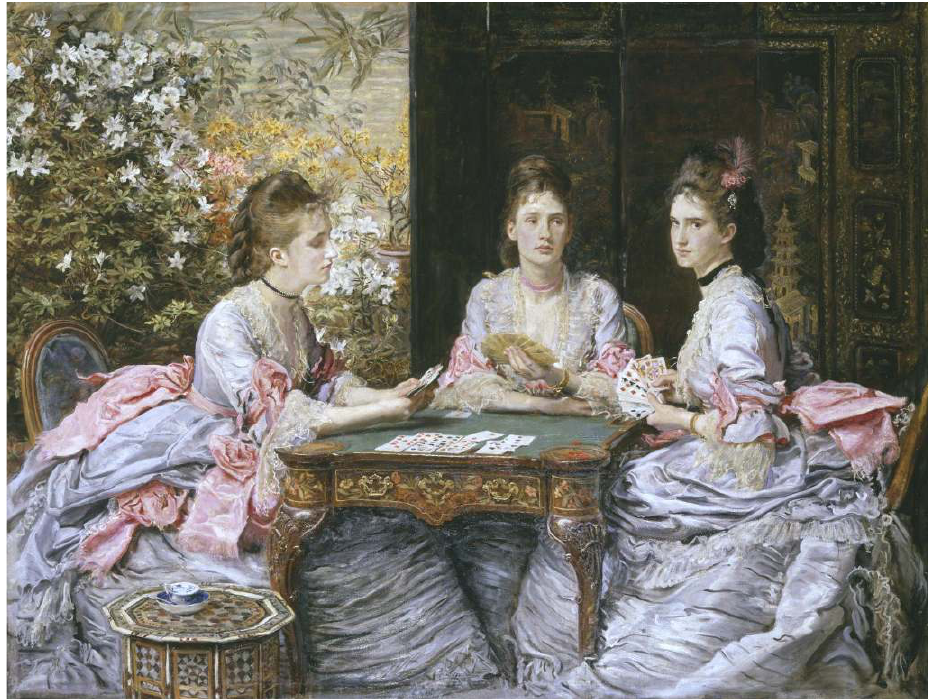
The title of this large piece — a commission from Walter Armstrong — works as double entendre. While it refers to the suit of cards (Hearts) chosen as trumps in a game of what could be bridge or whist, the presence of three young women at the table suggests there is more to it. They do not seem particularly interested in the game. Art history tells us that they are Armstrong’s daughters: Elizabeth, Diana and Mary on the right. The latter, looking straight at the viewer, is holding most of the trump cards, which makes the picture a possible allusion to the competition the sisters are engaged in to fi nd a husband. The literary quality of the painting cannot but remind the viewers of Jane Austen’s novels (see Jean-Jacques Lecercle’s article). Source: London, Tate Modern Gallery. https://www.tate.org.uk/art/artworks/millais-hearts-are-trumps-